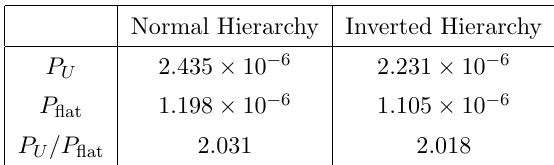
Table 4 . Probability test for the mixing angles and phases of the complex seesaw ensembles with N = 3 and a (trivial) normalized (cid:13)at distribution. The probability P U and P (cid:13)at are obtained by integrating the normalized Haar measure and the (cid:13)at distribution over the experimental volume V exp de(cid:12)ned by the data at the 1 (cid:27) con(cid:12)dence level (see table